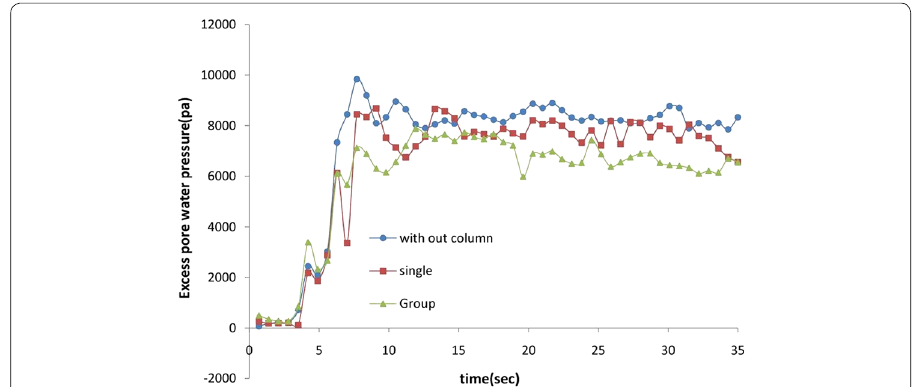
Fig. 19 Effect of stone columns in reducing excess pore water pressure without considering their drainage performance